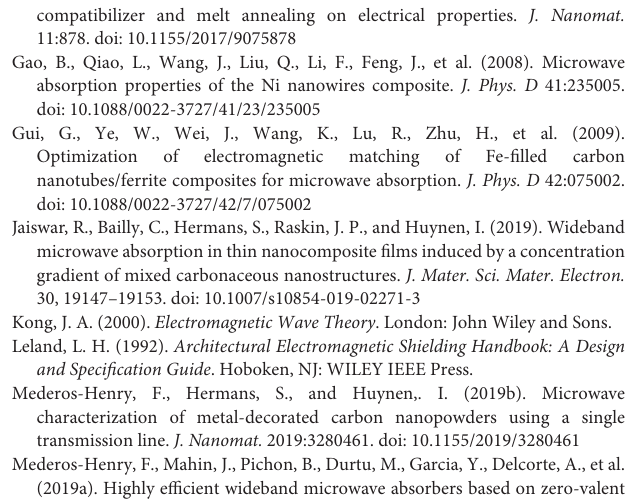
Table 2 provides the FOM for the 5 topologies of absorbers proposed in this work, deduced from the absorption curves presented in sections Polymer Gradient Absorber to Magnetic Gradient